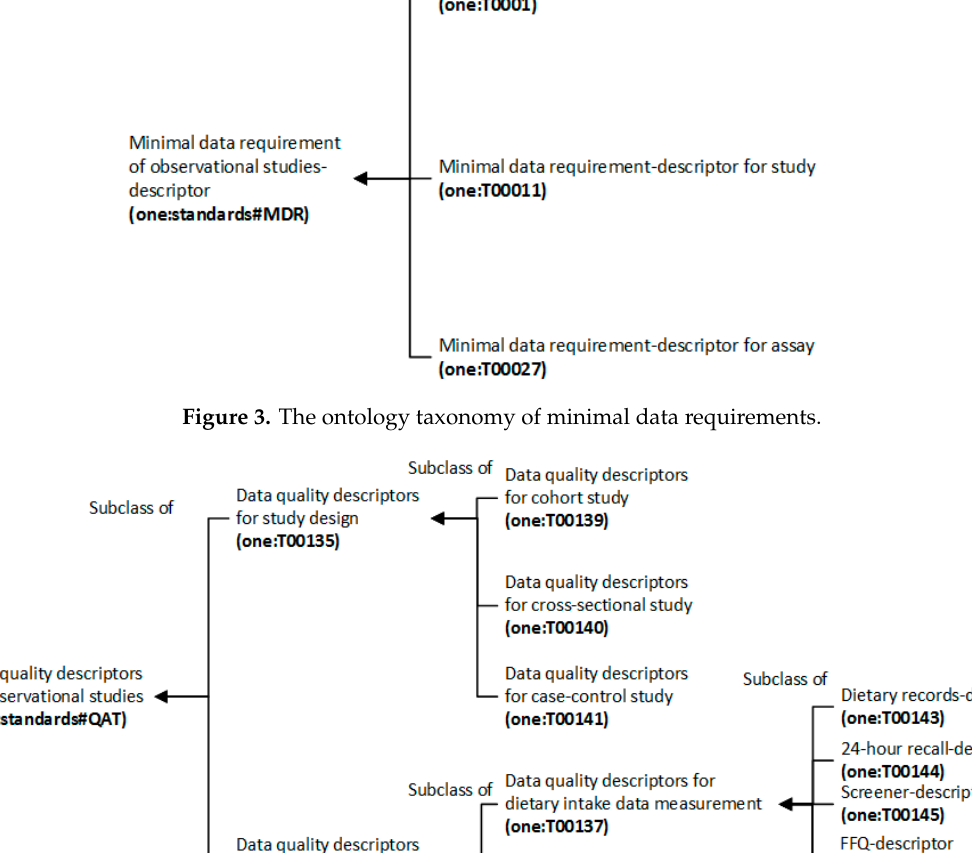
Figure 3. The ontology taxonomy of minimal data requirements.